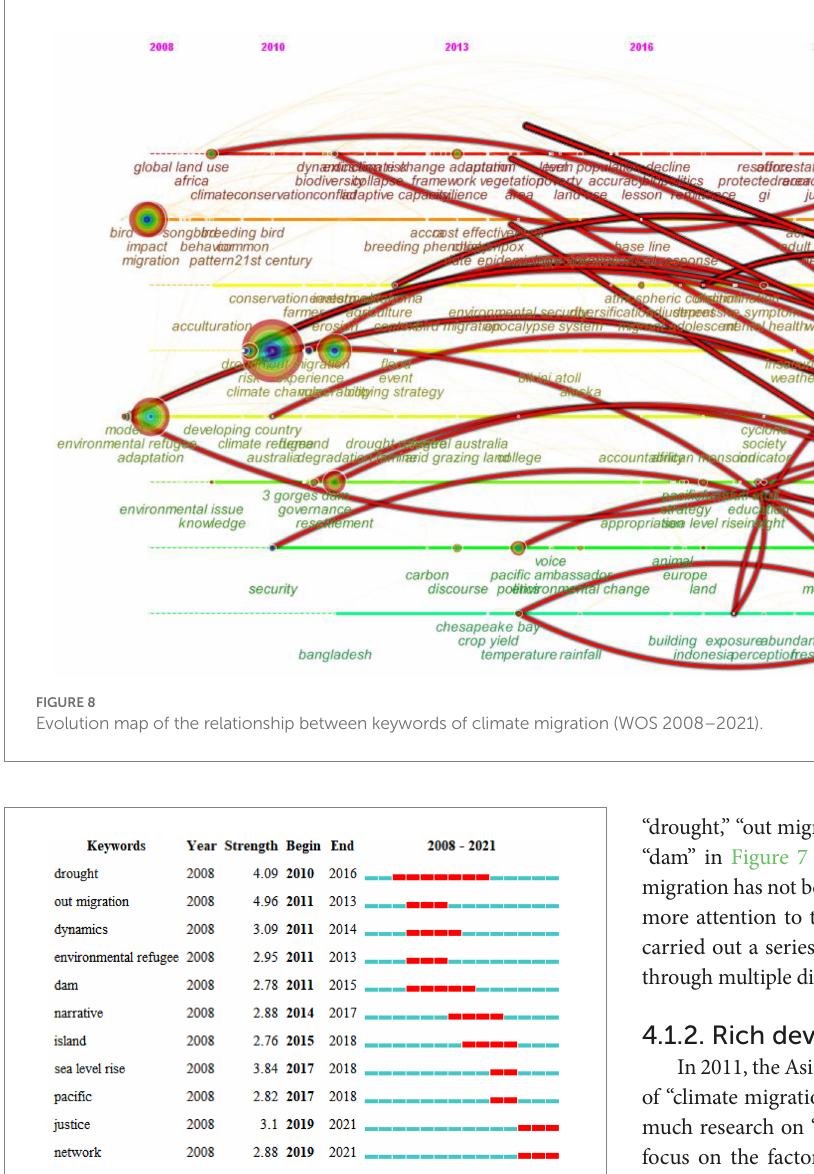
FIGURE 9 Burst detection keyword map of climate migration (WOS 2008–